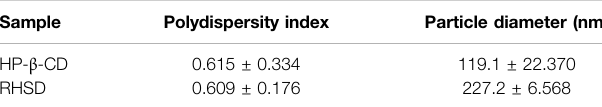
TABLE 2 | Polydispersity indexes (PDI) and average diameter ofHP- β -CD and the RHSD complex. Sample